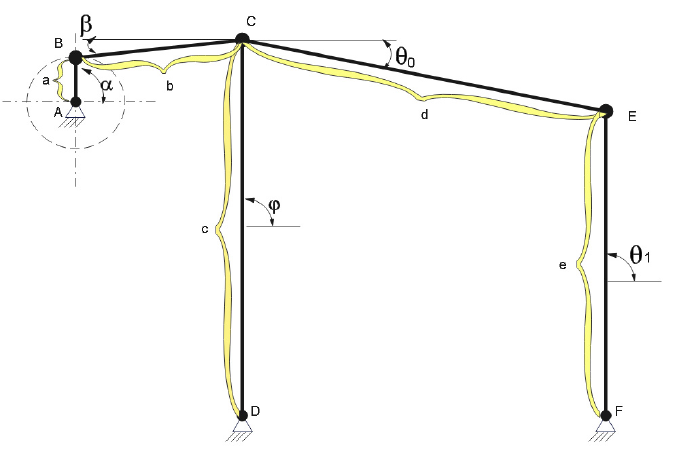
Figure 4. Dimensional elements of the studied mechanism.